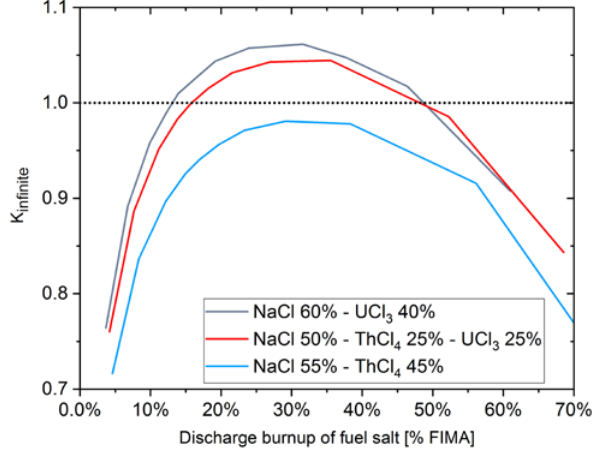
Figure 1. Comparison between fuel salts. Neutron multiplication factor as a function of average burnup for different salts, with continuous non-soluble products removal